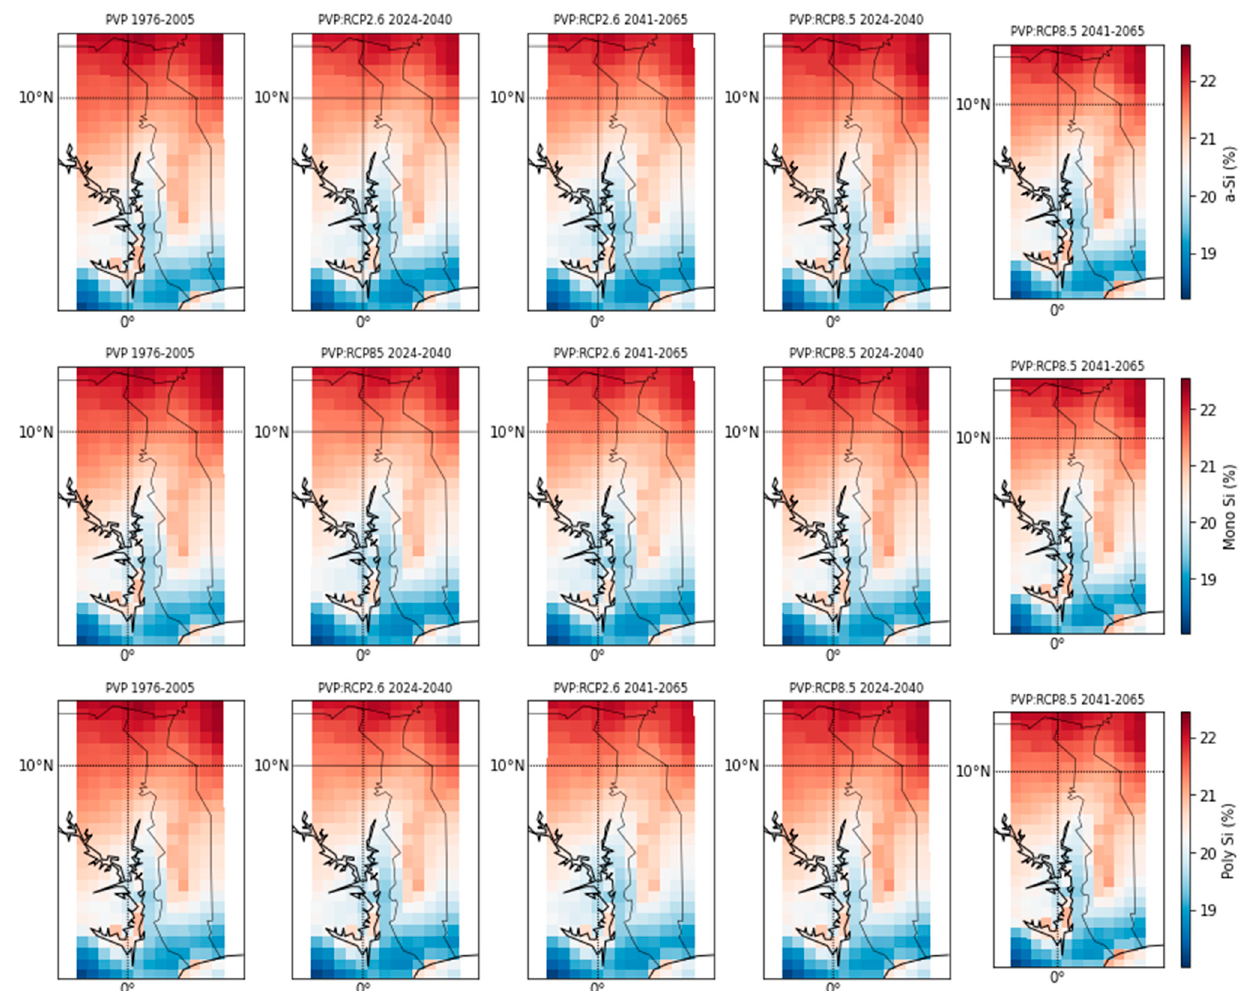
Figure 9. Projected annual and spatial changes in PVP in Togo under RCP2.6 and 8.5.